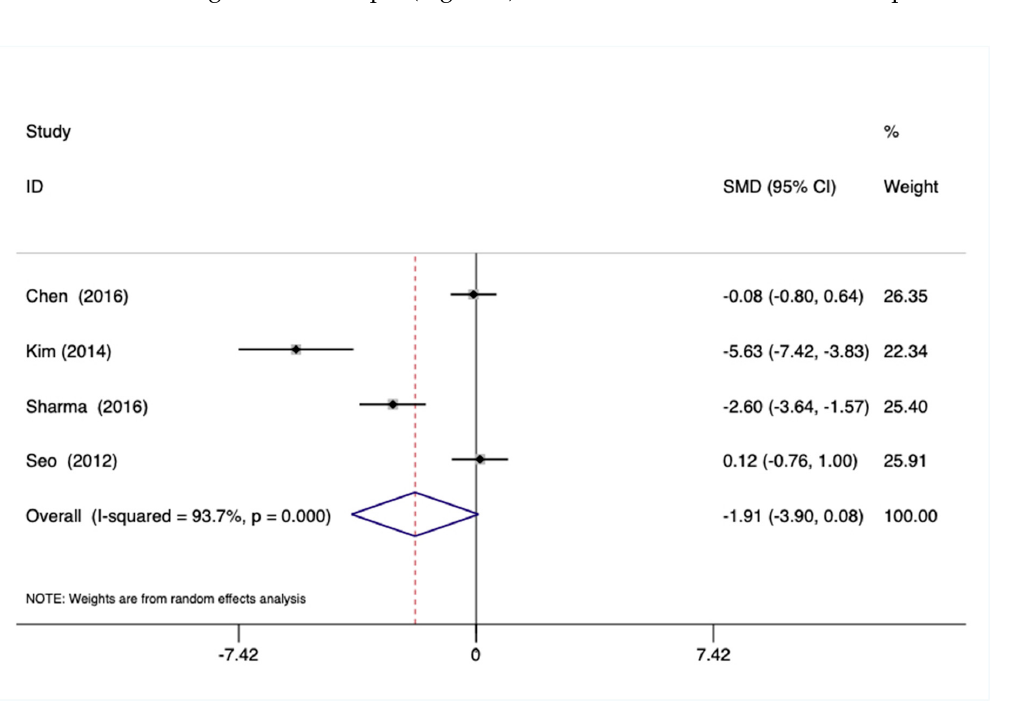
Figure 3. Forest plot showing the weighted pooled effect of Mind–Body physical activity interventions on blood glucose.